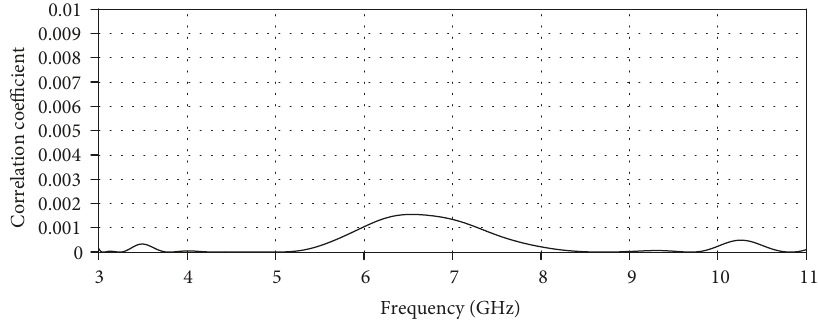
Figure 12: Simulated envelope correlation coe ffi